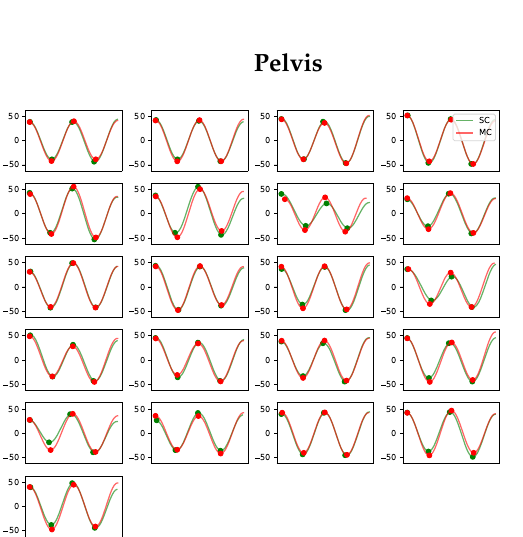
Figure A19. Vertical displacement signals per stride for the head and pelvis for horse 20. Each subplot contains the matched stride segments for the single-camera markerless system (SC) in green and the multi-camera marker-based system (MC) in red. The y-axis shows the vertical displacement in millimeters. The four dots on each curve indicate the positions of the two peaks and two valleys extracted using the approach in Section